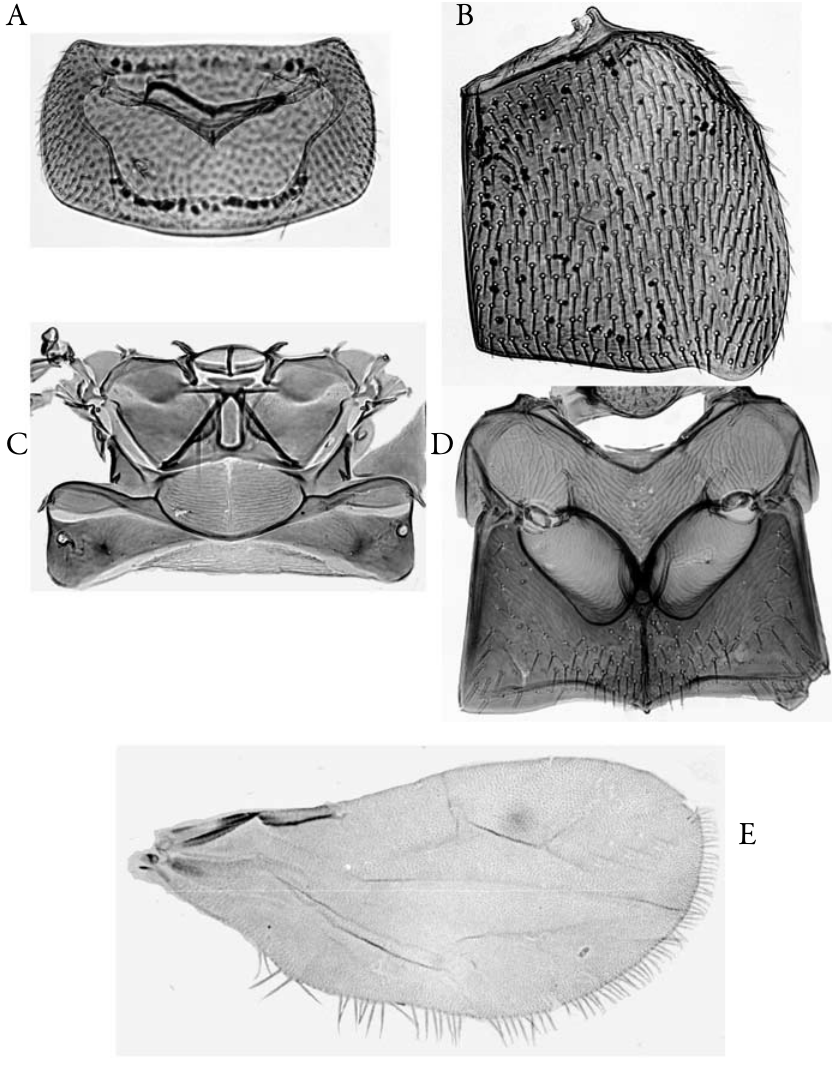
Fig. 3. Atheta dominguesae ,: A, Pronotum, dorsal; b, Left elytron; c, Meonotum; metanotum, and abdominal segment 1';D, Meso-and metasternum; e, Fig. 5e. spermatheca shaped as in Fif 5c. color dark reddish brown throughout with head, abdomen and legs a